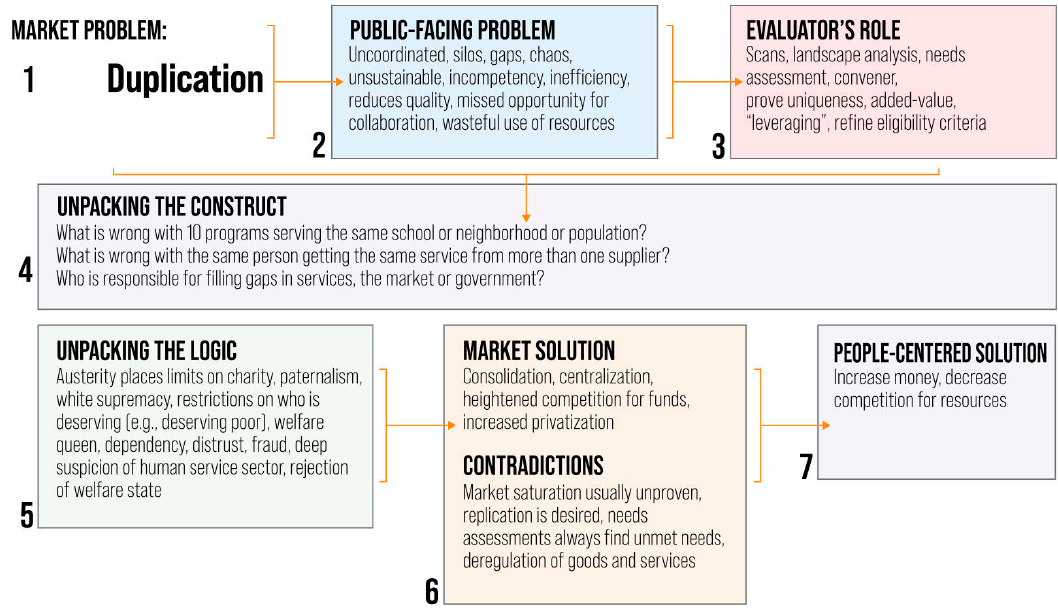
Figure 2. An example of how market logic becomes conventional wisdom in evaluation.